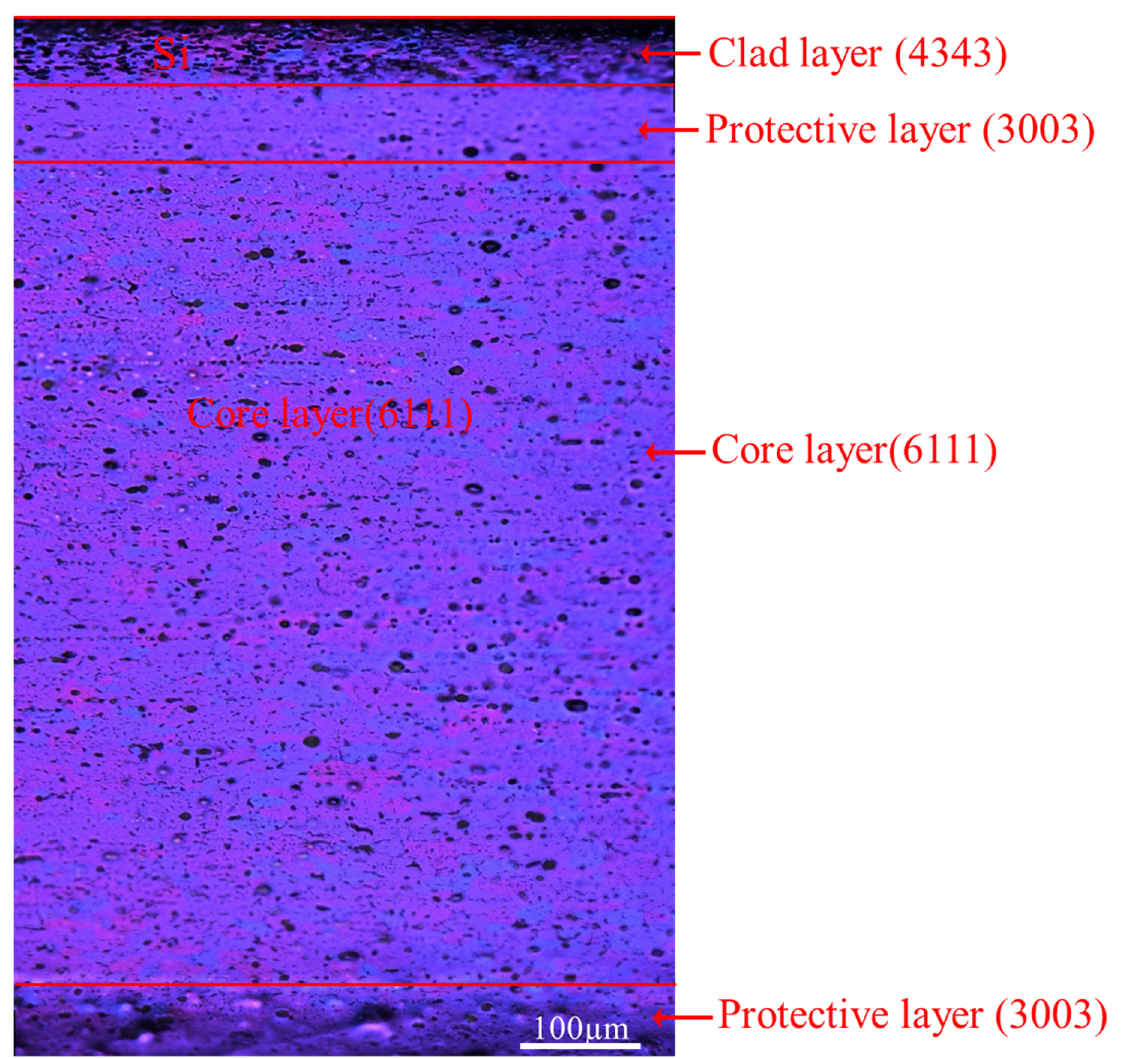
Figure 4. Cross-sectional microstructure of brazing sheet.